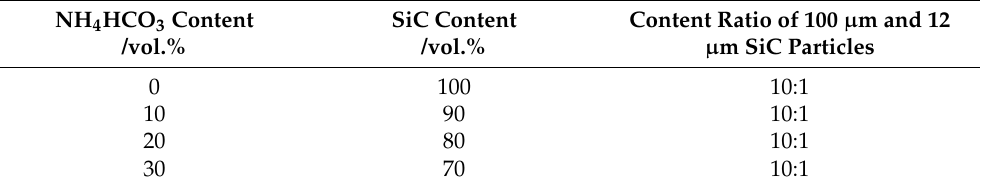
Table 2. Experimental scheme of the different content of NH 4 HCO 3 .